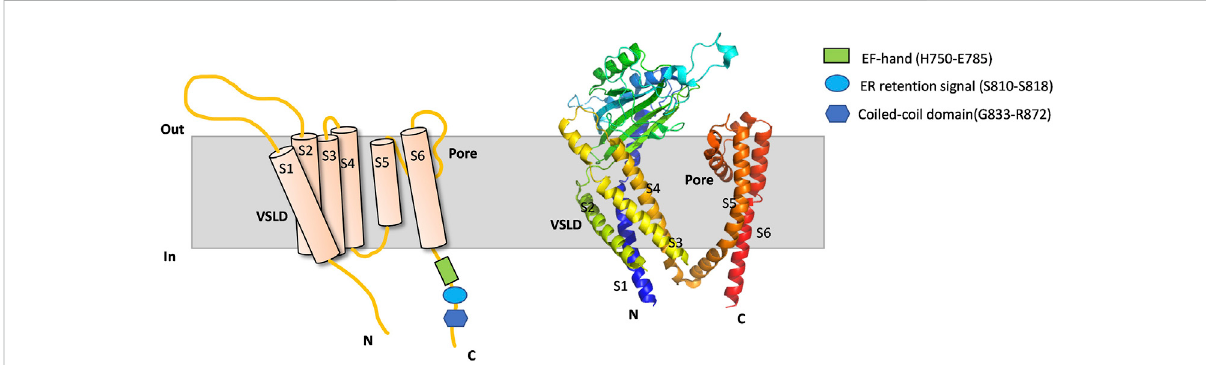
FIGURE 1 PKD2 membrane topology and Cryo-EM structure. Schematic illustration (left) and cryo-EM structure (PDB: 5T4D) (right) outlining a protomer of PKD2. Membrane, intracellular N- and C-terminus, VSLD, pore domain, TM domain (TM1-TM6), EF-hand, ER retention signal and coiled-coil domain are